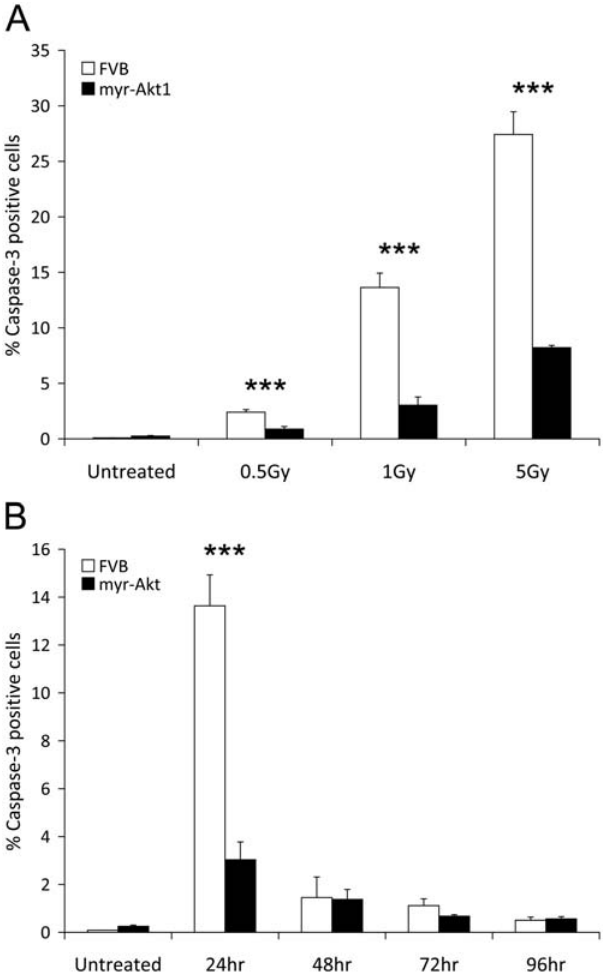
Figure 1. Reduced apoptosis in myr-Akt1 parotid glands following exposure to ionizing radiation. In A, four-week old female FVB and myr-Akt1 mice were exposed to 0.5, 1, or 5 Gy c - radiation and parotid salivary glands were removed 24 hours post- irradiation. Tissues were embedded into paraffin and sections were stained for activated caspase-3. The number of caspase-3 positive cells is graphed as a percentage of the total number of cells per field of view. In B, four-week old female FVB and myr-Akt1 mice were exposed to 1 Gy c -irradiation and parotid salivary glands were removed at 24, 48, 72 and 96 hours. Tissues were processed for activated caspase-3 immunohistochemistry as described in A. Five fields of view were quantitated for each tissue section and graphed using the averages and SEM from three mice per group. Significant differences (p # 0.05) were determined using a two sample t-test comparing FVB to myr-Akt1 and significant differences are marked with an asterisk (*).